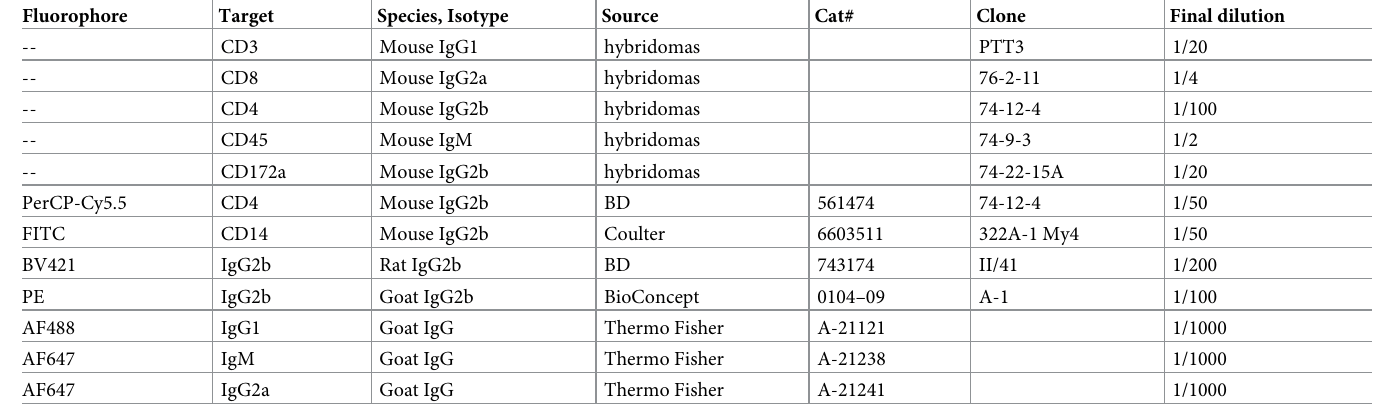
Table 1. List of